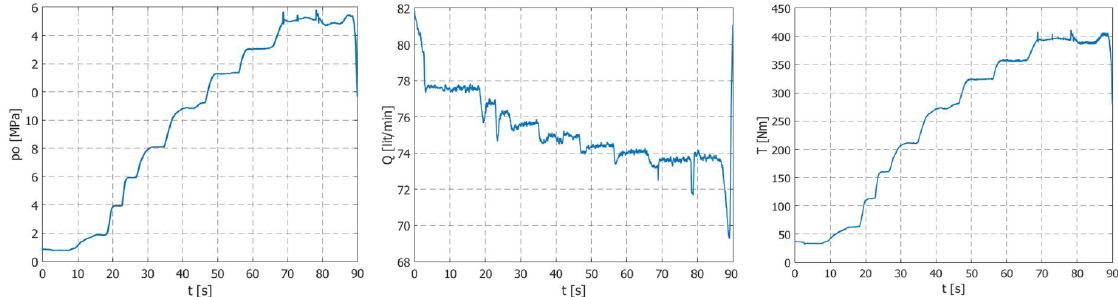
Figure 7. Diagram of dependence of the output pressure, working fluid’s flow rate, and torque of the pump shaft over time in the IR3 operating mode.